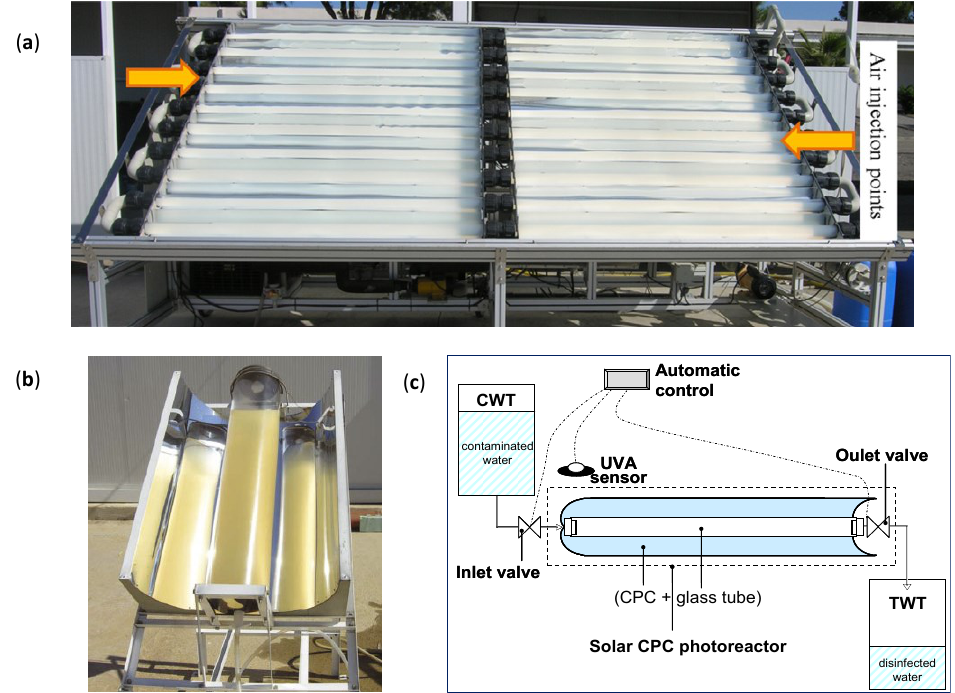
Figure 7. ( a ) Images of front view of the solar 60 L-CPC reactor at PSA facilities (4.5 m 2 of collector mirrors) with air injection points indicated; ( b ) Enhanced SODIS batch reactor filled with 100 NTU turbid water; ( c ) Schematic of the sequential batch